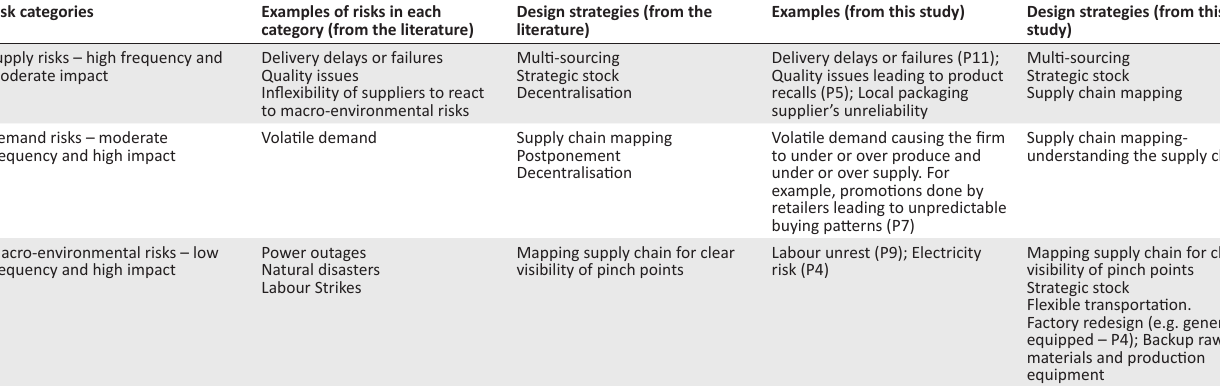
TABLE 6: Link between risks and mitigating supply chain design approaches – a comparison between the literature and findings of this study. Risk